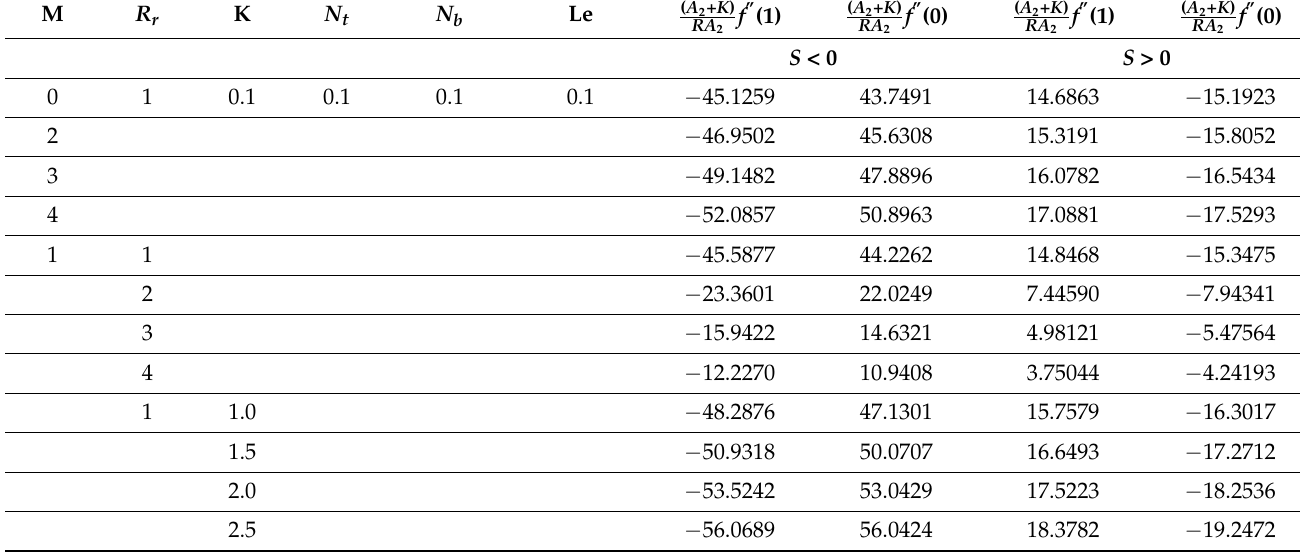
Table 3. Skin friction coefficient for γ Al 2 O 3 − H 2 O at lower and upper plane with weak interaction n =